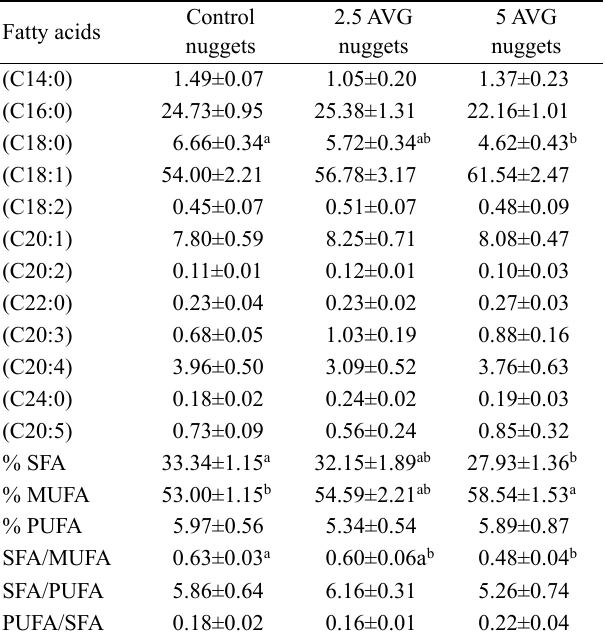
Table 3. Effect of Aloe vera gel addition on the fatty acid profile (% of total fatty acid) of goat meat